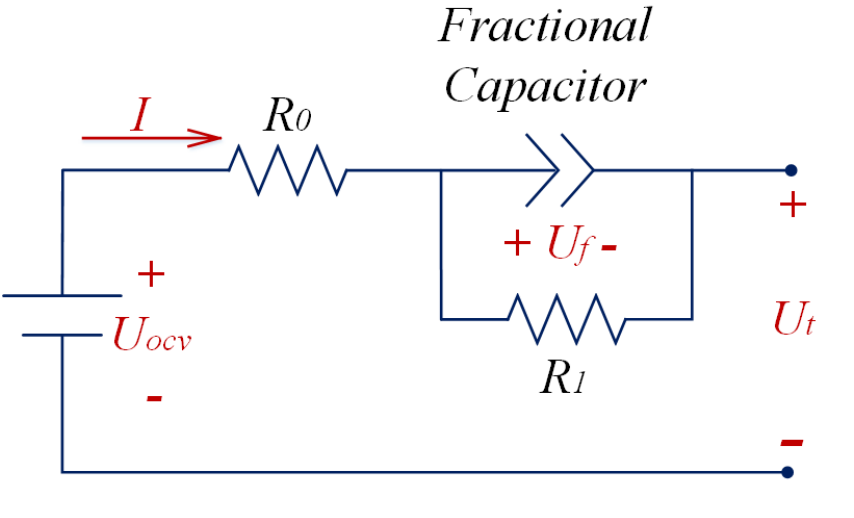
Figure 3. Equivalent circuit of the fractional derivative model of a battery under an instantaneous load